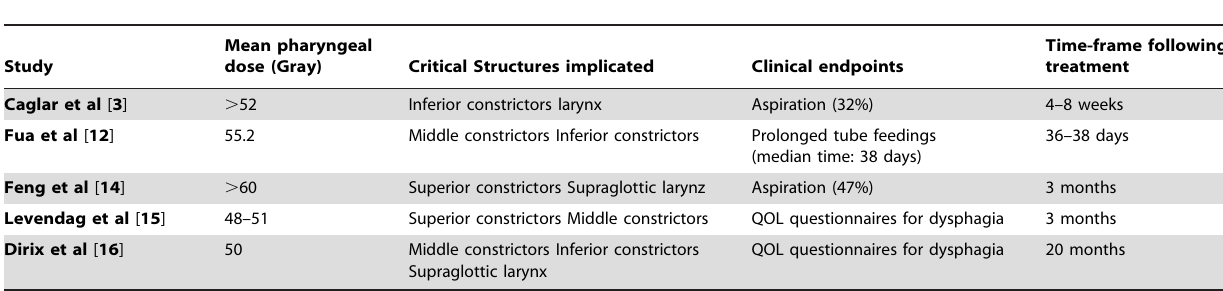
Figure 2. Illustrating the potential of Tomotherapy to spare the pharyngeal muscles in a patient who had postoperative chemoradiation for locally advanced base of tongue and bilateral neck metastases. Even though the right neck was dissected and required radiation of the surgical bed and scars to 63 Gy, the pharyngeal muscles can still be spared from excessive radiation dose. The midline laryngeal block with the split field intensity-modulated radiotherapy technique would have had underdosed the surgical scar and area of the surgical bed located in close proximity to the larynx and the gross lymph nodes on the left side. The patient is in remission 13 month after treatment. doi:10.1371/journal.pone.0056290.g002 amount of dysphagia and aspiration used techniques which choice for non-hypopharyngeal and non-laryngeal head and neck cancer [8]. The additional advantage of WF-IGRT is the excellent and inferior pharyngeal constrictor muscles [12,20]. Thus, WF- regional control in the presence of cervical lymph nodes because of IGRT, by virtue of its laryngeal and pharyngeal muscle sparing the delivery of high dose to these structures in the face of laryngeal and pharyngeal muscle sparing [13]. Table 2. Mean pharyngeal dose (Gy) correlation with dysphagia severity or aspiration reported in the